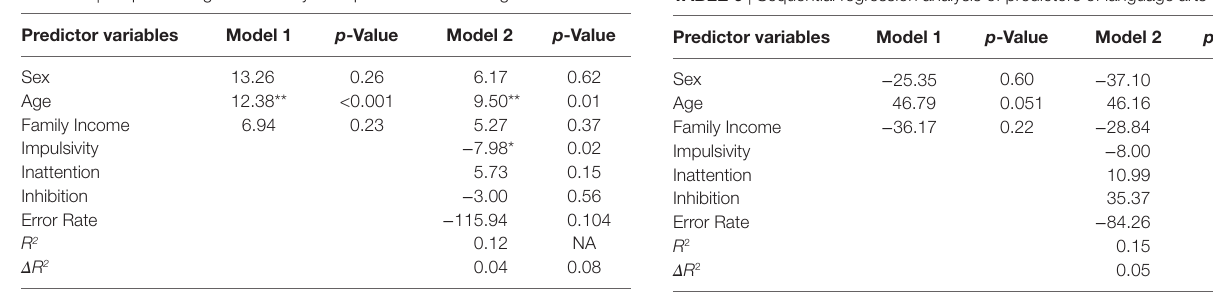
Table 3 | Sequential regression analysis of predictors of reading scores.